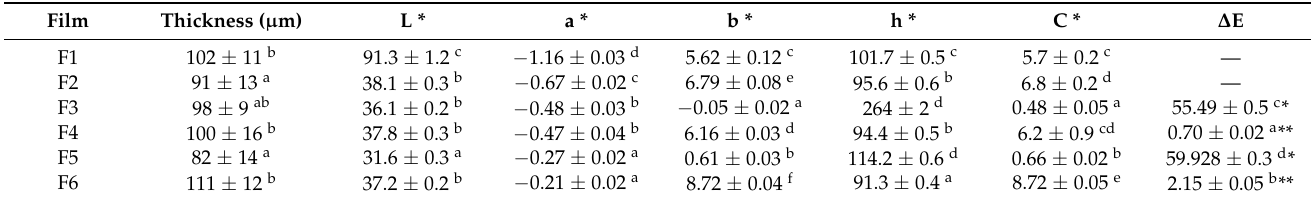
Table 2. Means and deviation standard of color parameters of the films.